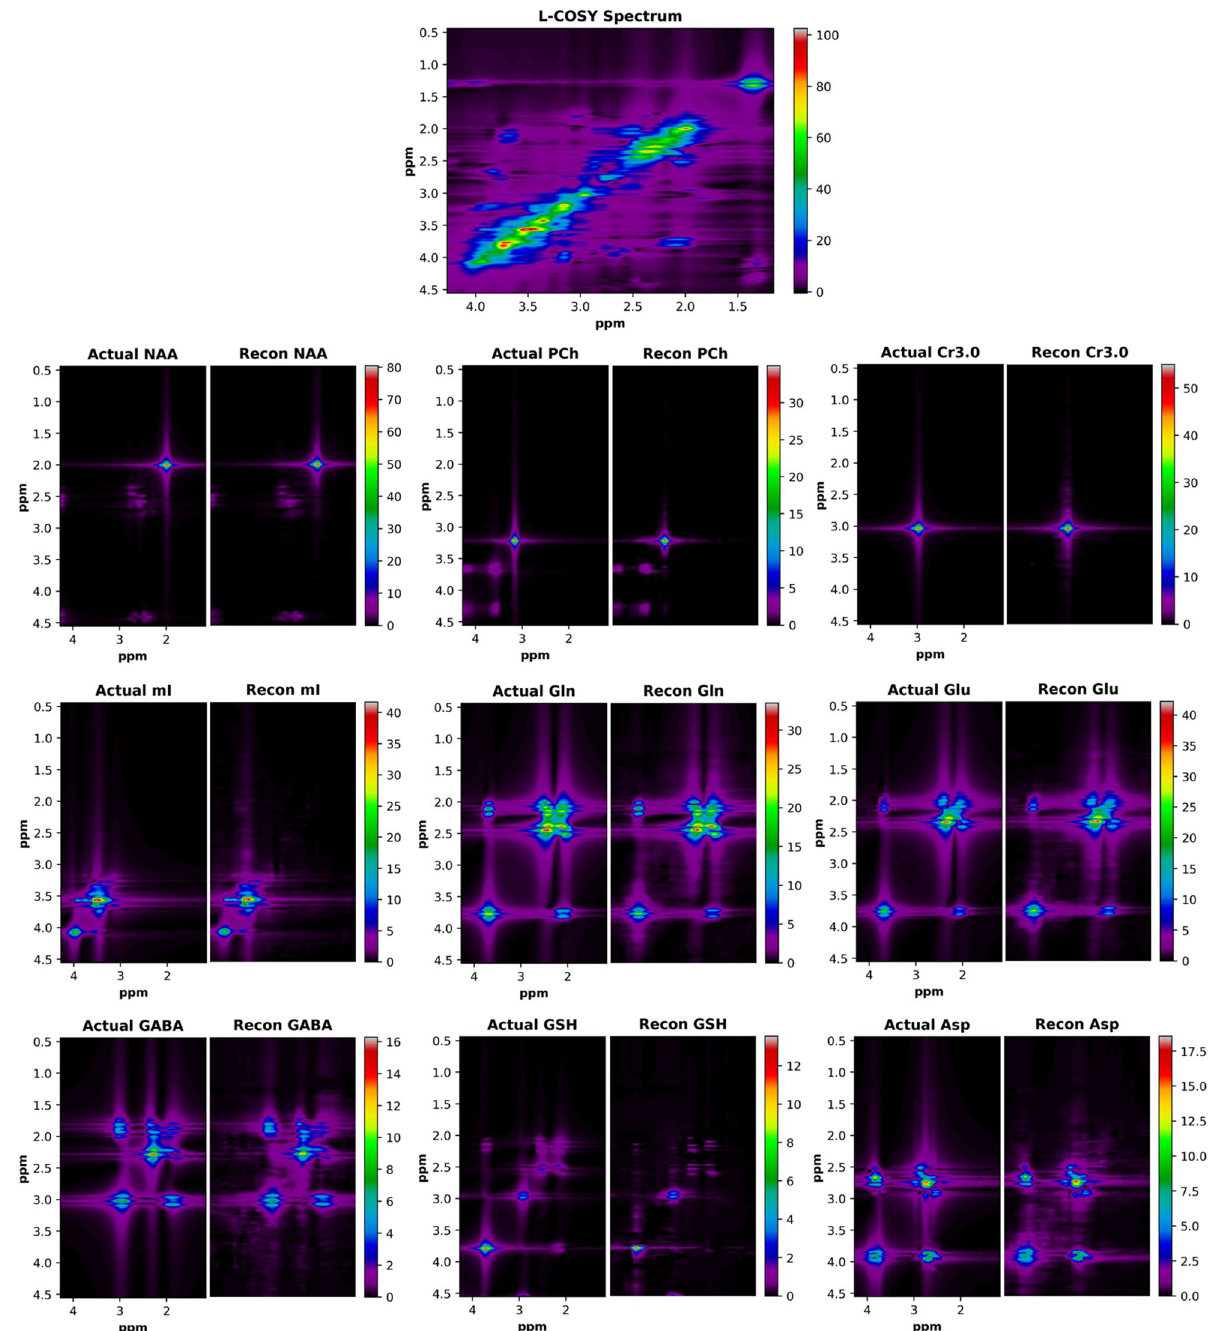
Figure 6. The results for the quantitation D-UNet are displayed for an example fully sampled L-COSY spectrum. From the input spectrum (top), the deep learning model reconstructs each metabolite’s magnitude spectrum individually (Recon). For comparison, the actual simulated magnitude spectra (Actual) are plotted alongside the reconstructed spectra with the same intensity windows. While only 9 metabolites are displayed, the D-UNet model produces 17 metabolite spectra. The concentrations for these spectra are proportional to the signal intensities, as is standard for most fitting